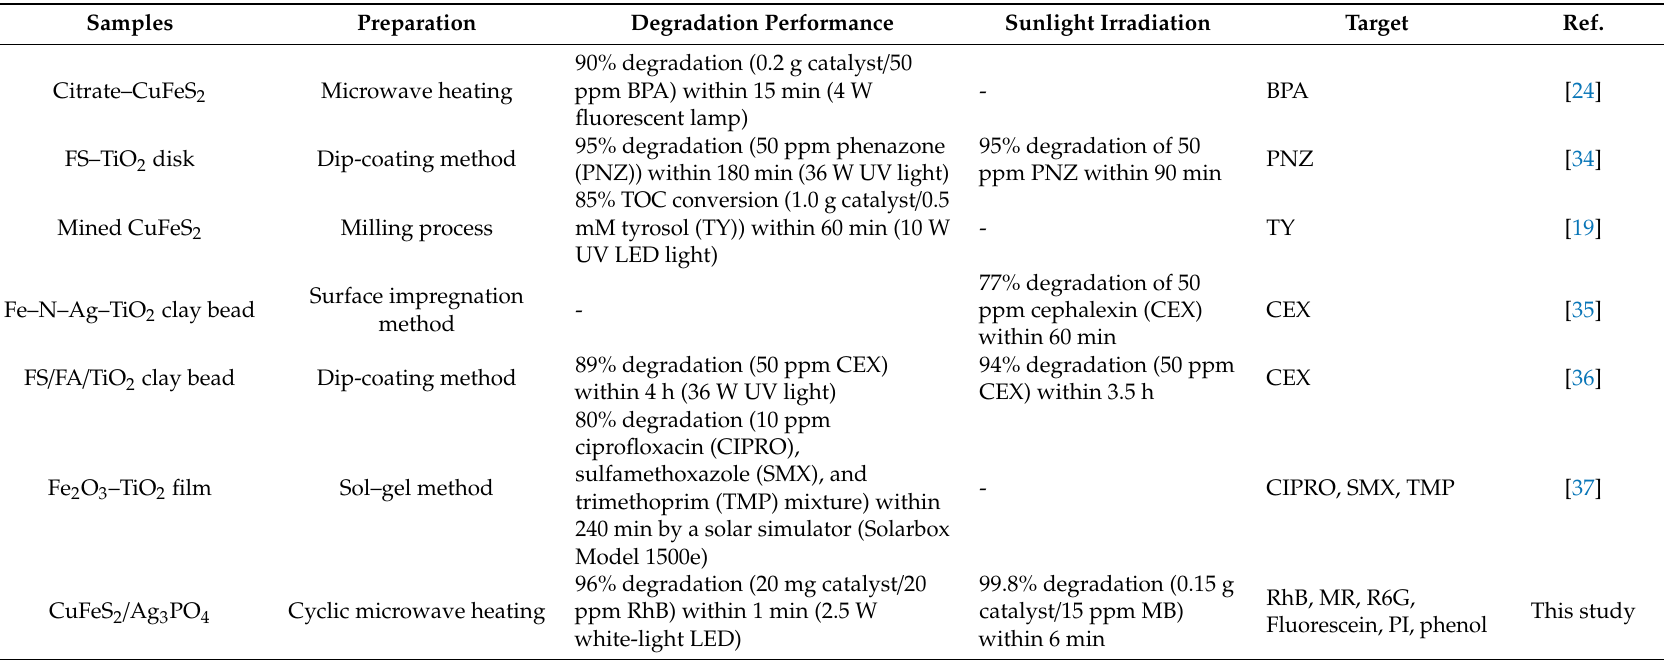
Table 2. Comparison of the degradation performance and practical applications using the photo-Fenton